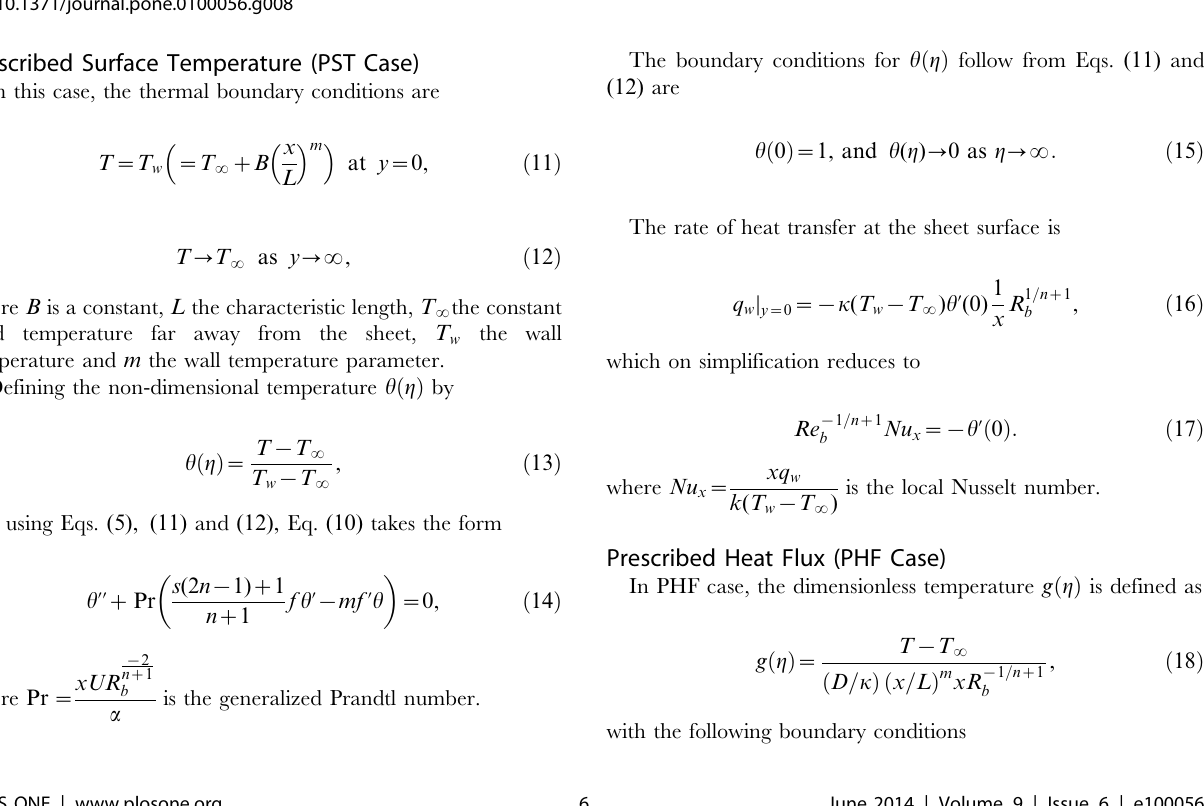
Figure 8. The temperature profile g g ð Þ in the PHF case for different values of the temperature parameter m when s ~ 1 : 5 , Pr ~ 1 and A ~ 1 are fixed.